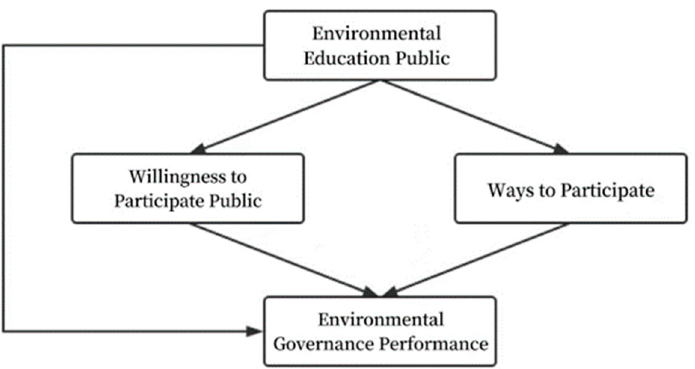
Figure 1. Theoretical structural model.